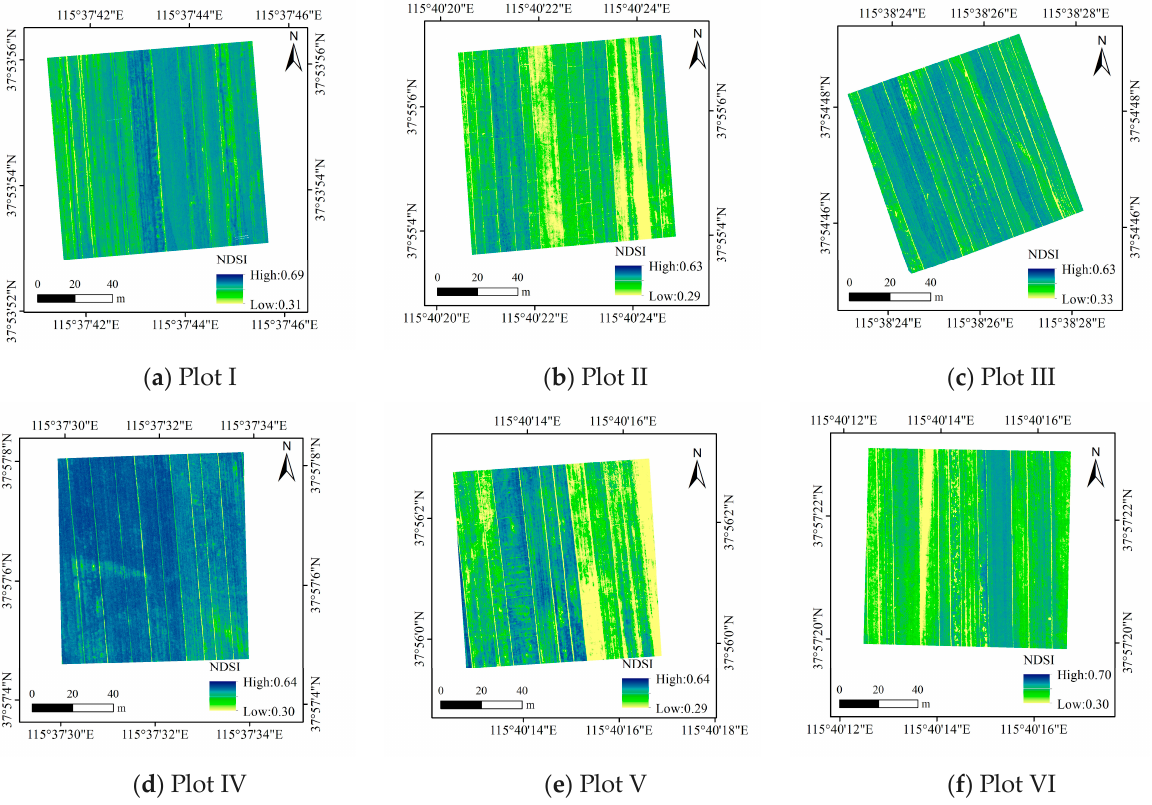
Figure 7. NDSI results of each flight plot based on the sensitive band centers λ (724 nm, 784 nm) (25 May 2021). Table 3. Statistics of the NDSI and D- f G in each flight plot in different crop growth